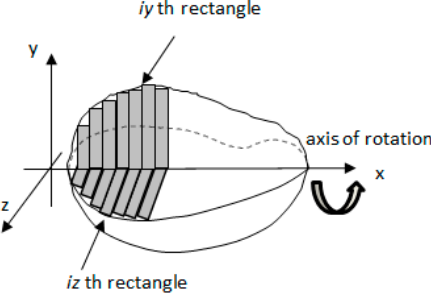
Figure 9. The outline image of Harumanis mango was assumed to be composed of individual rectangular elements.